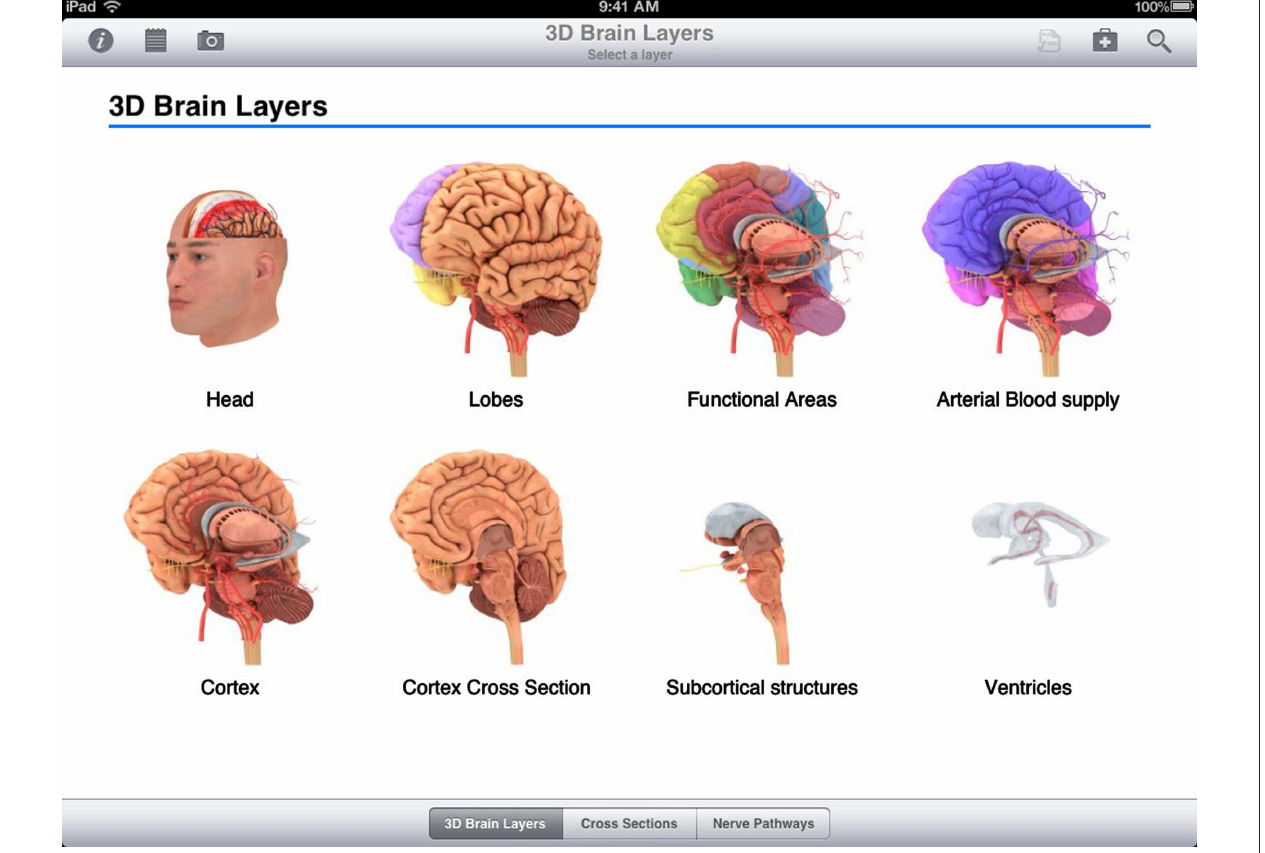
Figure 1 | Snapshot of 3D Brain Layers within the Pocket Brain